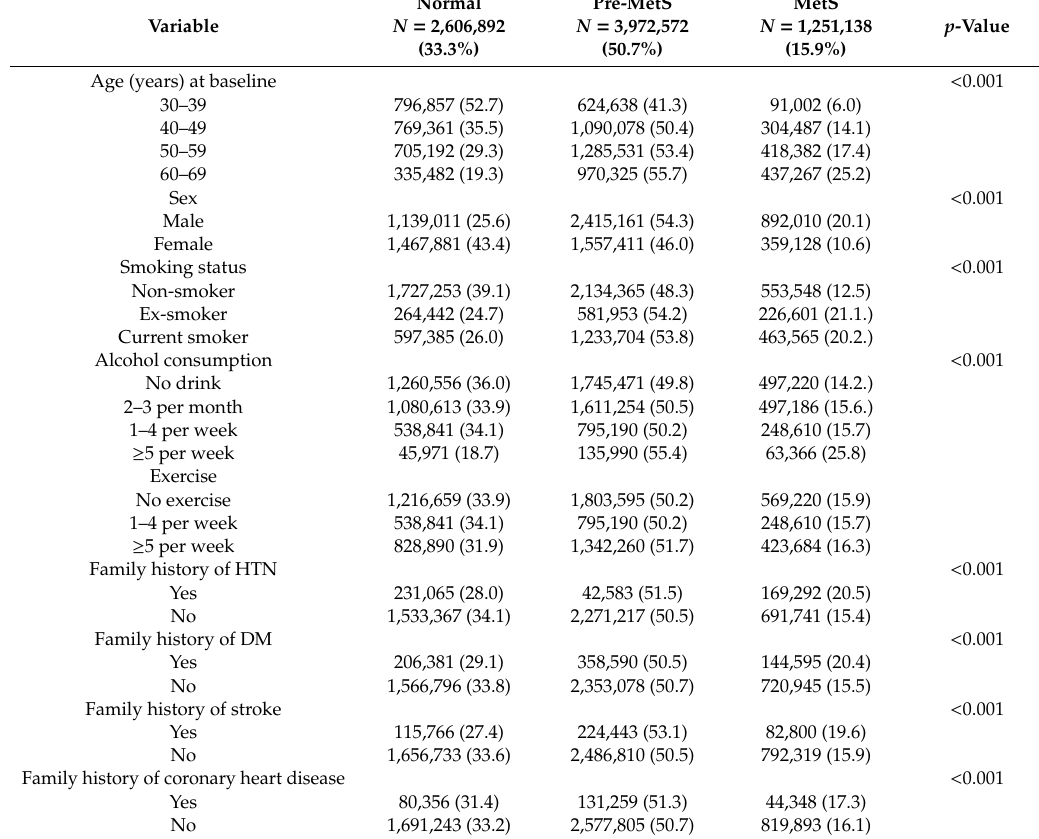
Table 1. Baseline characteristics of study population according to metabolic syndrome